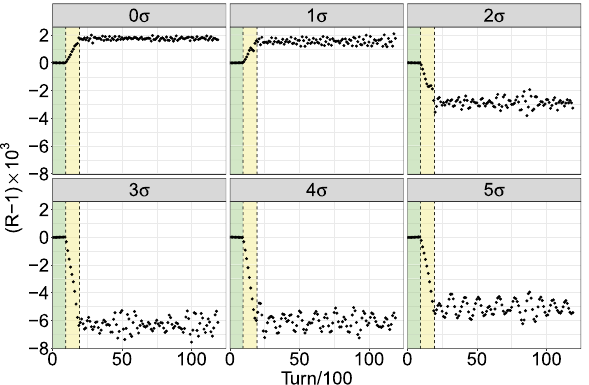
Fig. 7 ( R − 1 ) × 10 3 in the x -scan versus the “cycle” number, where R isdefinedin(3.20)andaveragedper“cycle”,i.e.withinnon-intersecting windows of 100 accelerator turns. Green and yellow bands delimited by the two vertical dashed lines correspond to N no BB turn = 1000 first turns without the beam–beam force and next N adiab turn = 1000 turns when it is being adiabatically switched on. The facet labels denote the bunch separation in the bunch sigmas. The simulated beam parameters are listed in Table